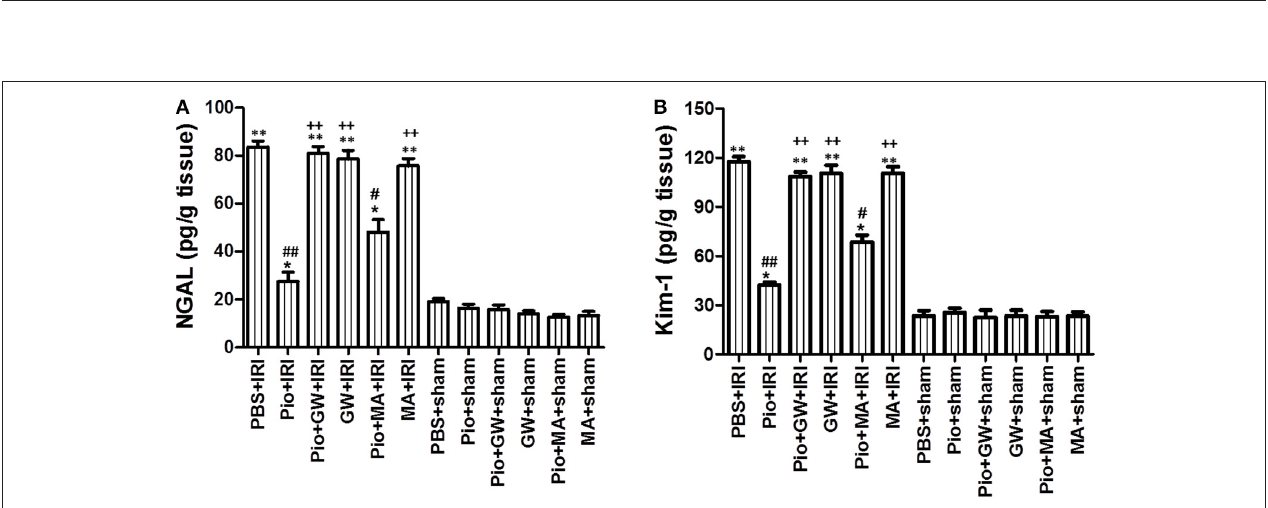
FIGURE 4 | Pioglitazone decreases renal NGAL and Kim-1. (A) Renal NGAL in different groups at 24h after renal IRI. (B) Renal Kim-1 in different groups at 24h after renal IRI. Data shown are means ± SE. Compared with the PBS + sham group, *represents for P < 0.05, **represents for P < 0.01; Compared with the PBS + IRI group, # represents for P < 0.01, ## represents for P < 0.01; Compared with the Pio + IRI group, ++ represents for P < 0.01. n = 6 in each group. NGAL, neutrophil gelatinase-associated lipocalin. Kim-1, kidney injury molecule-1.